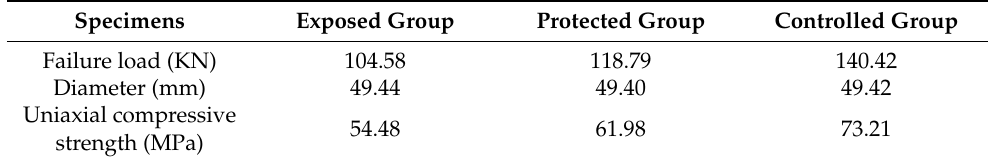
Table 3. Uniaxial compressive strength of